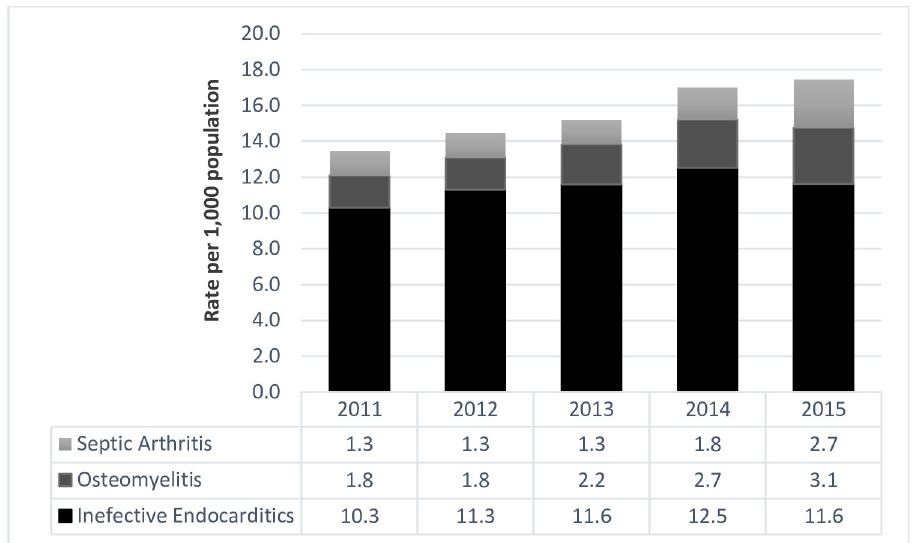
Fig 2. Incidence rate of deep tissue infections in the OAT population in